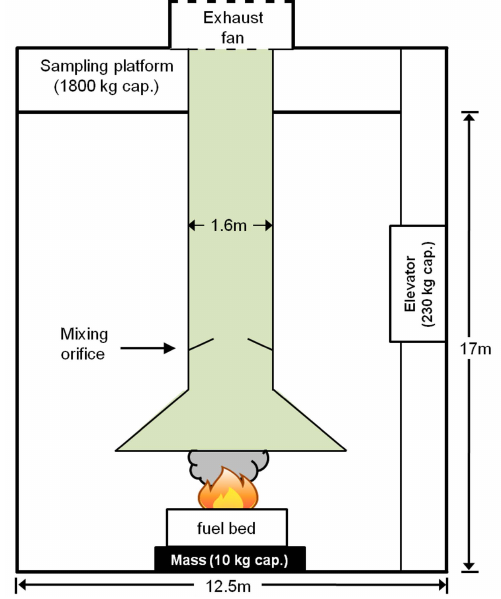
Fig. 1. Schematic of combustion chamber at Missoula